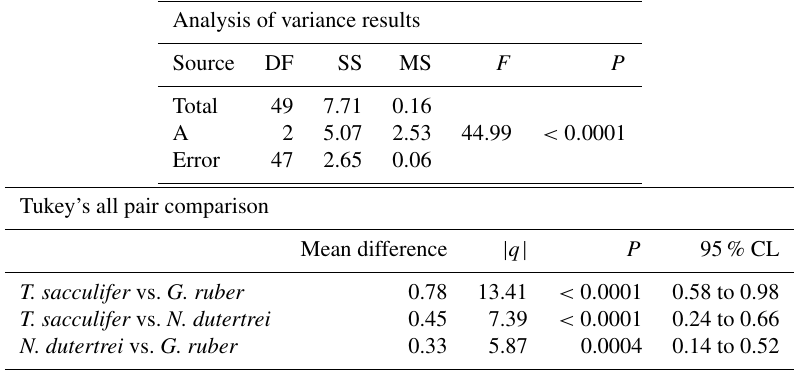
Table 4. Results of the ANOVA test comparing the means of the three different species uncorrected for vital effect: T. sacculifer , G. ruber and N. dutertrei